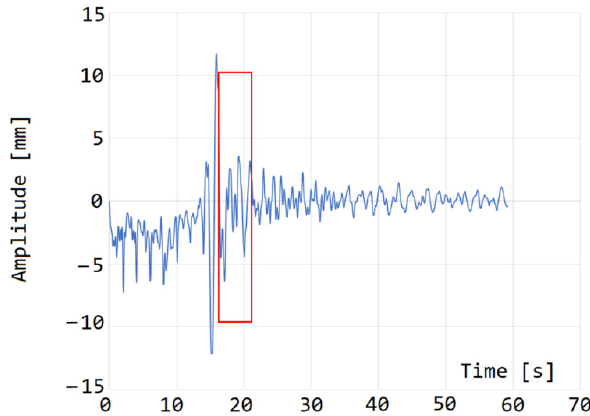
Figure 20. Model of the platform subjected to excitations similar to the 4 March 1977 earthquake.